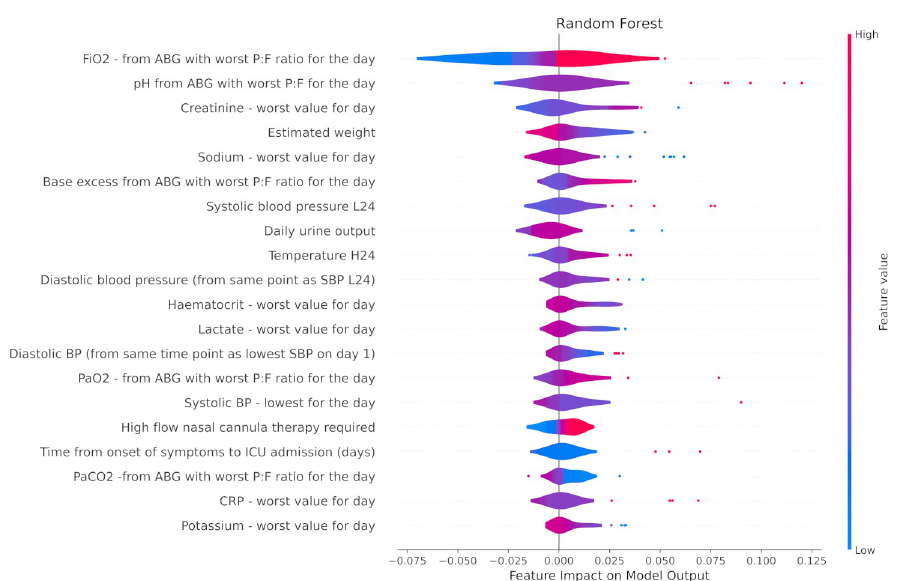
Fig 1. Summary plot showing the 20 most predictive features as defined by the RF model for correctly classified samples. H24—Highest in first 24 hours of hospital admission, L24—Lowest in first 24 hours of hospital admission. ‘Day’ refers to the first 24 hours of ICU admission unless otherwise specified. ’Worst’ refers to the worst value as relating to the APACHE II score. P:F ratio = PaO2 divided by